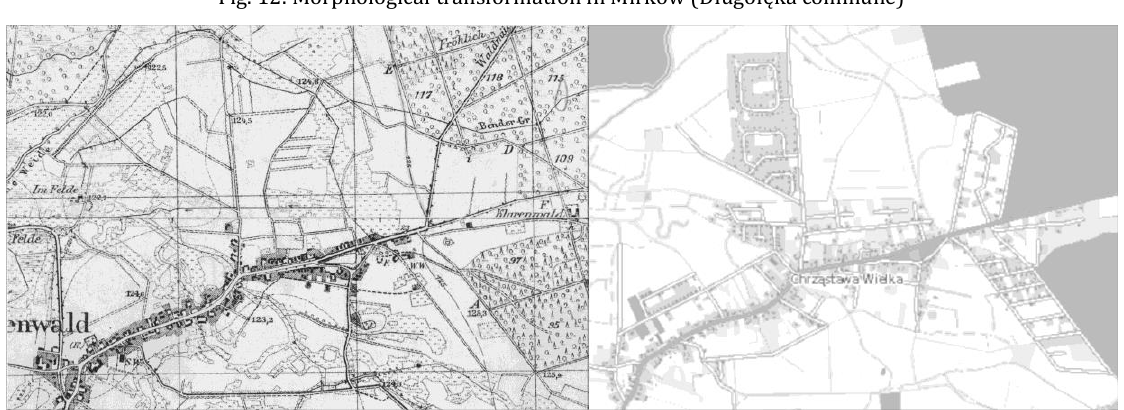
Fig. 13. Morphological transformation in Chrząstawa Wielka (Czernica